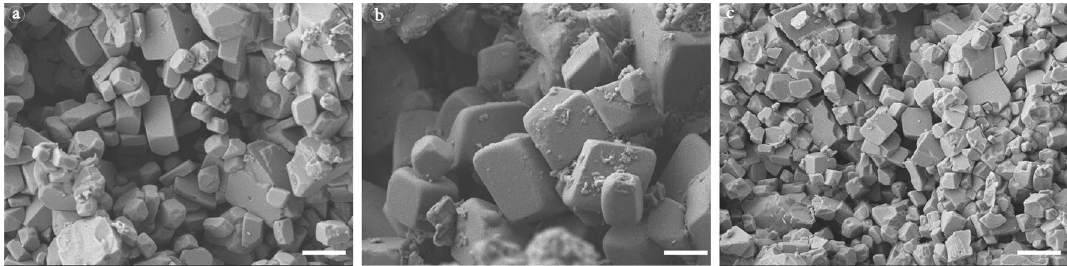
Figure 2. SEM images of rhombic calcite microcrystals from ( a ) Malacca limestone, ( b ) Stuart City Trend, and ( c ) Thamama Gp. Note that Malacca and Stuart City samples are characterized by rhombic microcrystals whereas Thamama sample is characterized by a mixture of rhombic and polyhedral crystals. All scale bars are 5